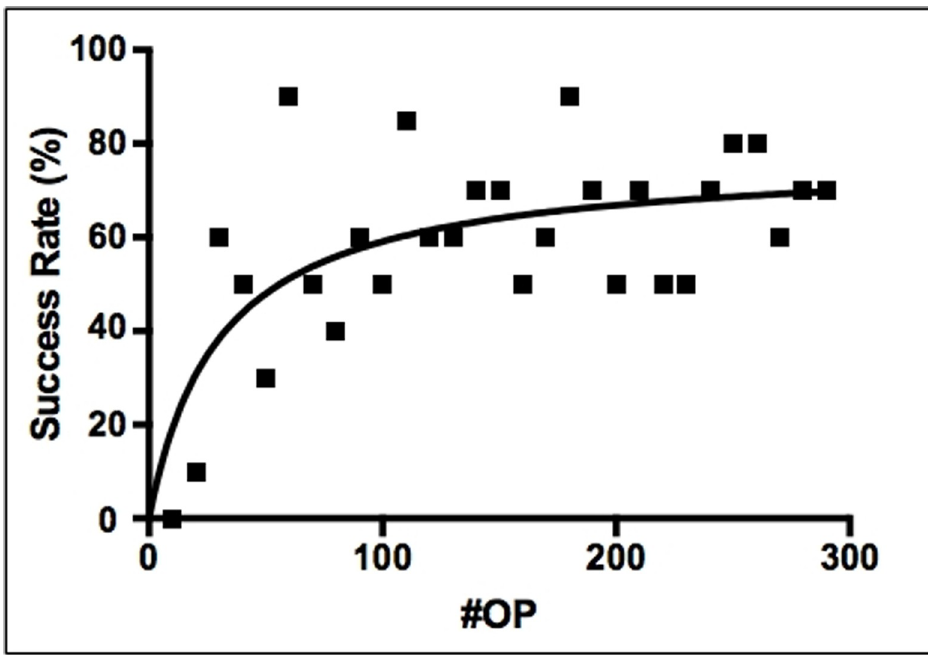
Fig 10. Graphical illustration of the learning curve: Success rate. Success was defined by a well-beating donor-heart after transplantation and survival of the recipient � 48 hours.